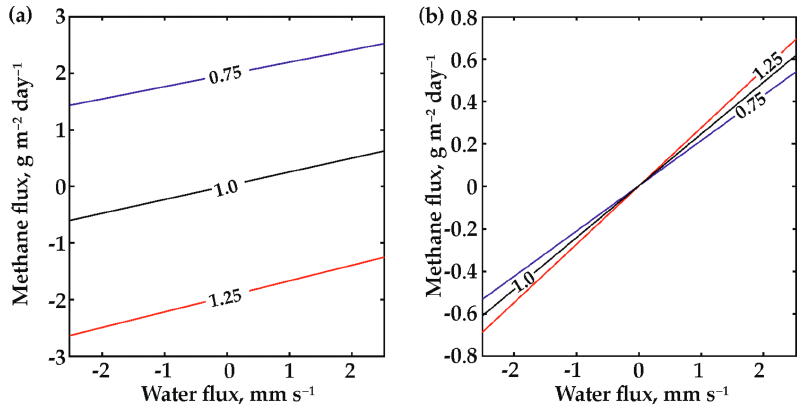
Figure 6. Direction of methane flux and water flux. ( a ) In unsaturated soils; ( b ) In saturated soils. Line labels denote dimensionless C 1 /C 2 , showing the initial methane distribution in a 0.6 m thick sample soil column, with C 2 = 178 mol, and equilibrium pressure. In saturated soils, methane flux always follows water flux.